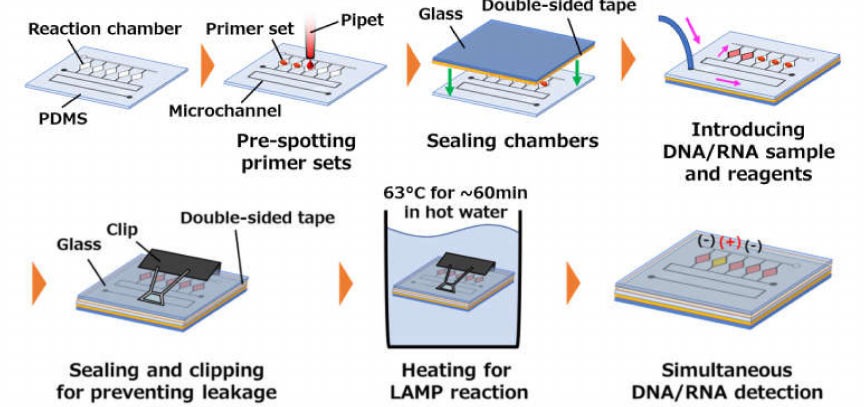
Figure 3. Operating procedure for the multiplex loop-mediated isothermal amplification (LAMP) assay employed in microfluidic diagnostic devices for the simultaneous detection of DNA- and RNA-based plant viruses.